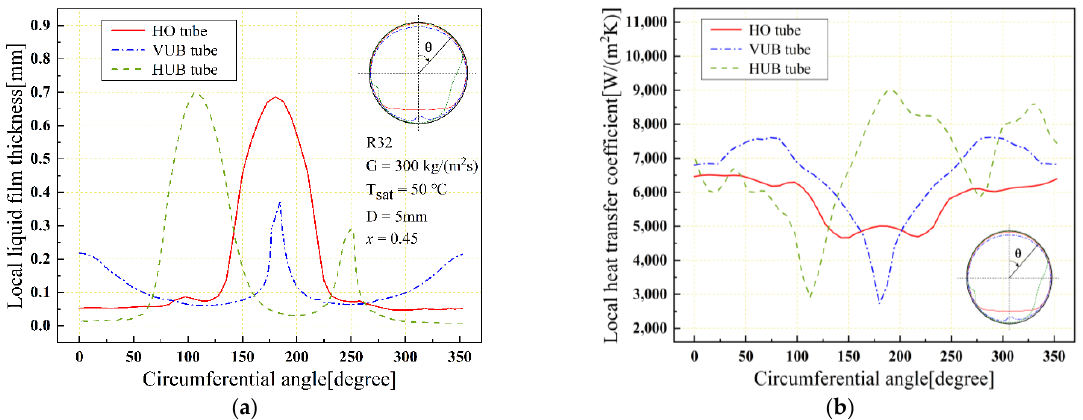
Figure 12. Distribution of local liquid film thickness and local heat transfer coefficient under different tubes. ( a ) Local liquid film thickness; ( b ) local heat transfer coefficient.